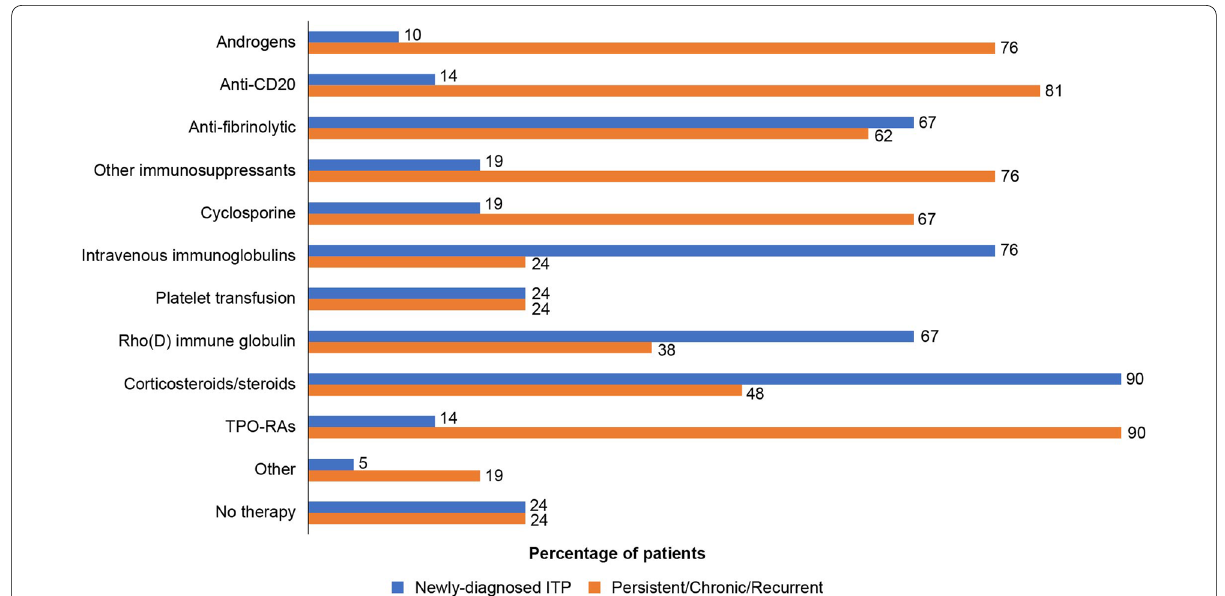
Fig. 6 Management of ITP – Prescribed